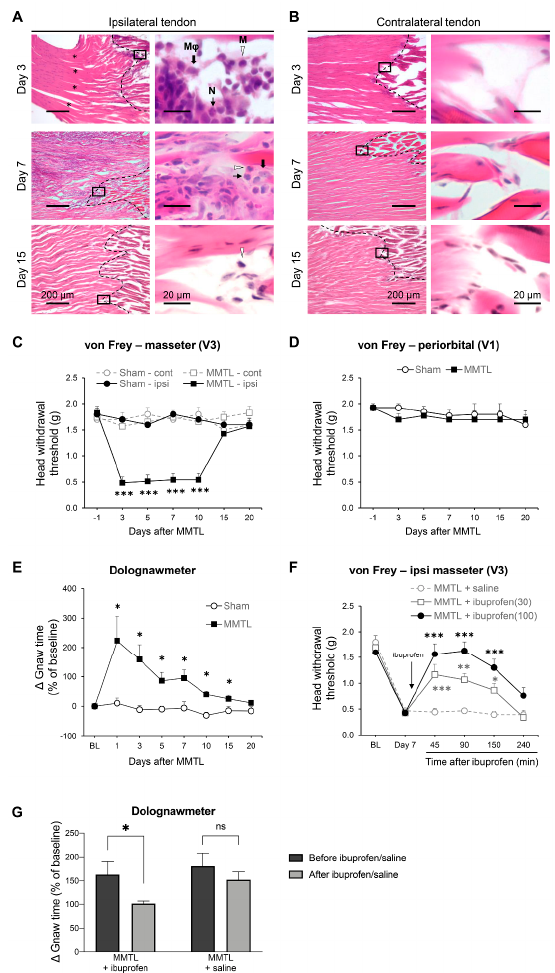
Figure 1. MMTL produces inflammation in the tendon tissue, masseter muscle allodynia, and gnawing dysfunction. ( A , B ) Representative H&E staining images of ipsilateral ( A ) and contralateral ( B ) masseter tendon on days 3, 7, and 15 after MMTL. The right panels of the images display the respective boxed areas in the left panels at higher magnification. The asterisks (*) indicate the site of the MMTL injury. The dashed lines indicate the edge between tenocytes and masseter muscle cells. M φ , macrophage; M, monocyte; N, neutrophil. The representative staining was repeated three times to confirm our results. ( C , D ) MMTL decreased the head withdrawal threshold in the skin area over the masseter muscle ( n = 6–7; ( C )), but not in the periorbital region ipsilateral to MMTL surgery ( n = 6–7; ( D )). F treatment (3, 22) = 48.990, p < 0.001. F time (6, 132) = 7.637, p < 0.001; F interaction (18, 132) = 8.466, p < 0.001 for ( C ). F treatment (1, 11) = 6.076, p = 0.031. F time (6, 66) = 0.860, p = 0.529; F interaction (6, 66) = 0.819, p = 0.560 for ( D ). ( E ) MMTL increased gnaw time (sham, n = 8; MMTL, n = 10). F treatment (1, 16) = 10.750, p < 0.05; F time (7, 112) = 5.261, p < 0.001; F interaction (7, 112) = 3.780, p < 0.001. *** p < 0.001, ** p < 0.01, * p < 0.05 vs. the respective sham or saline control. ( F ) Oral administration of ibuprofen produced a dose-dependent increase in head-withdrawal threshold in the skin area over the masseter muscle in mice with MMTL ( n = 6 per group). F treatment (2, 15) = 17.260, p < 0.001; F time (5, 75) = 46.370, p < 0.001; F interaction (10, 75) = 6.906, p < 0.001. *** p < 0.001, ** p < 0.01, * p < 0.05 vs. the respective sham or saline control. ( G ) Oral administration of ibuprofen (100 mg / kg) on day 7 post MMTL significantly decreased the gnaw time in the dolognawmeter assay, while saline treatment did not have such e ff ect ( n = 6 per group). * p < 0.05 vs. before treatment by Student’s t-test. ns: no significance; MMTL: masseter muscle tendon ligation; ipsi: ipsilateral; cont: contralateral; BL: baseline; ibuprofen(30): 30 mg / kg of